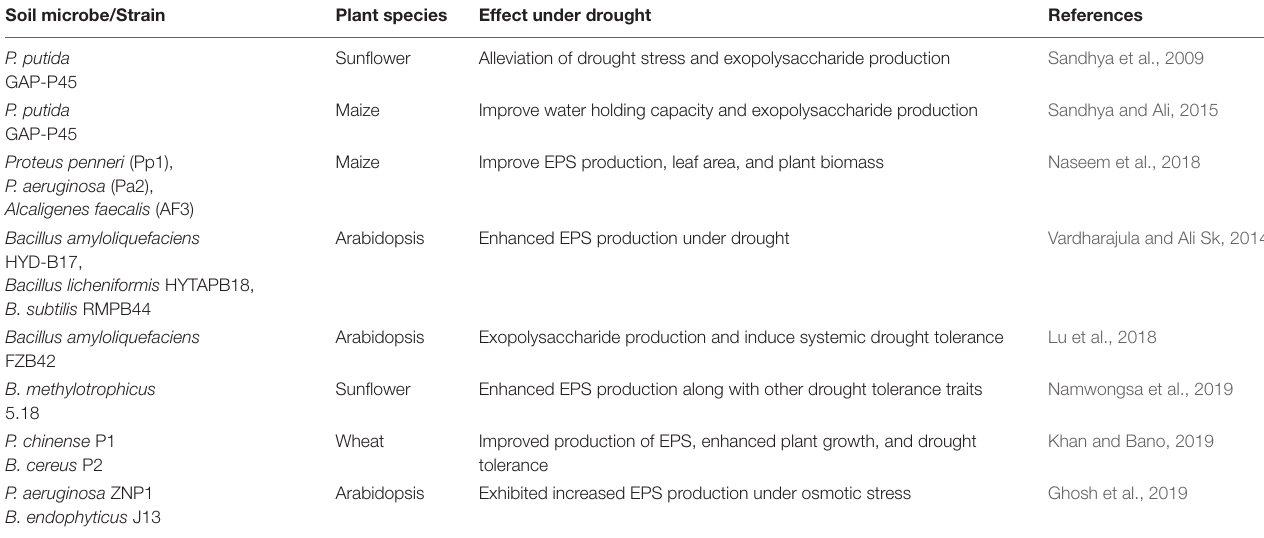
TABLE 3 | Mitigation of drought stress through EPSs produced by